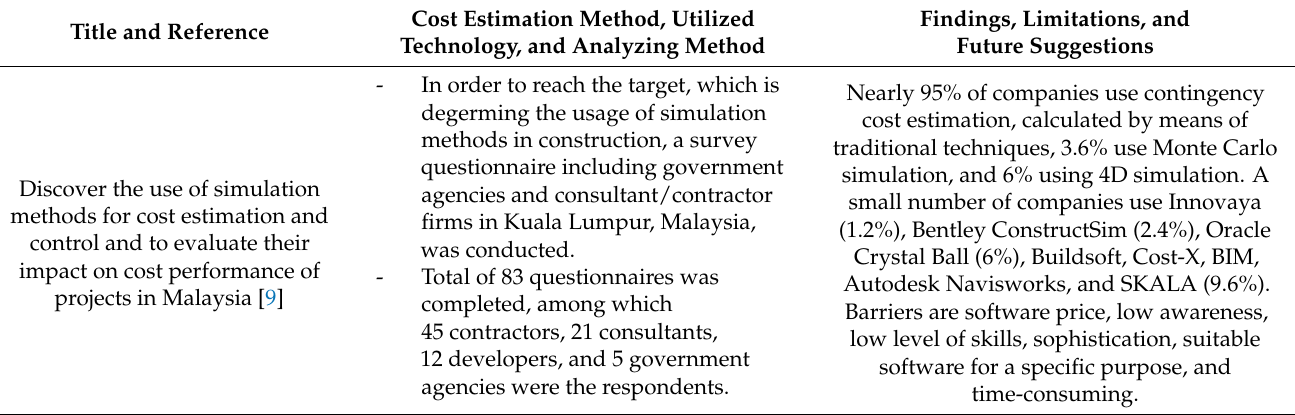
Table 4. Summary of papers focused on BIM implementation for a bill of quantity, risk paths, and cost overruns, the application of new cost estimation methods such as simulation techniques, or BIM applications in construction projects (Cluster